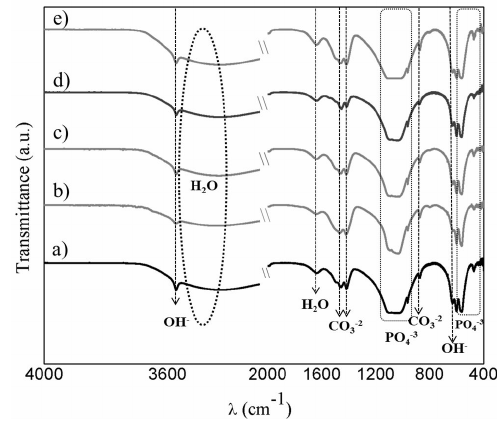
Figure 5. FTIR spectra of the (a) HAS0.5-600, (a) HAS1-600, (c) HAS2-600, (d) HAS3-600 and (e) HAS4-600